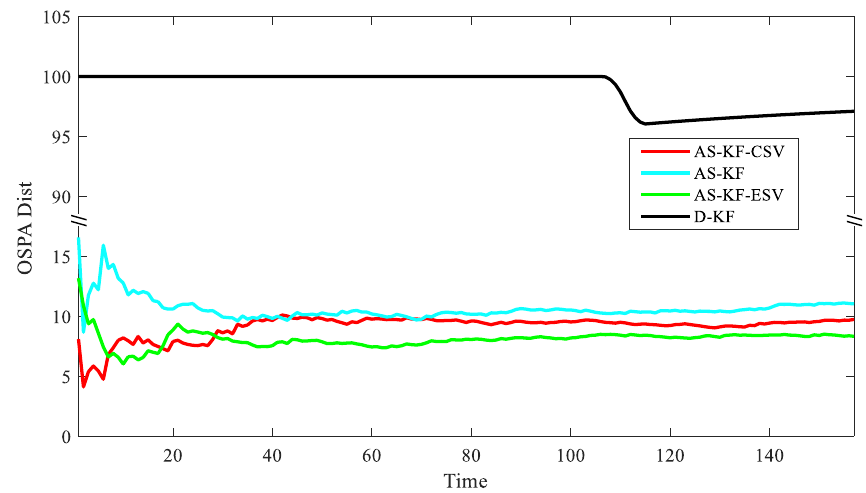
Fig. 6 Performance comparison of different